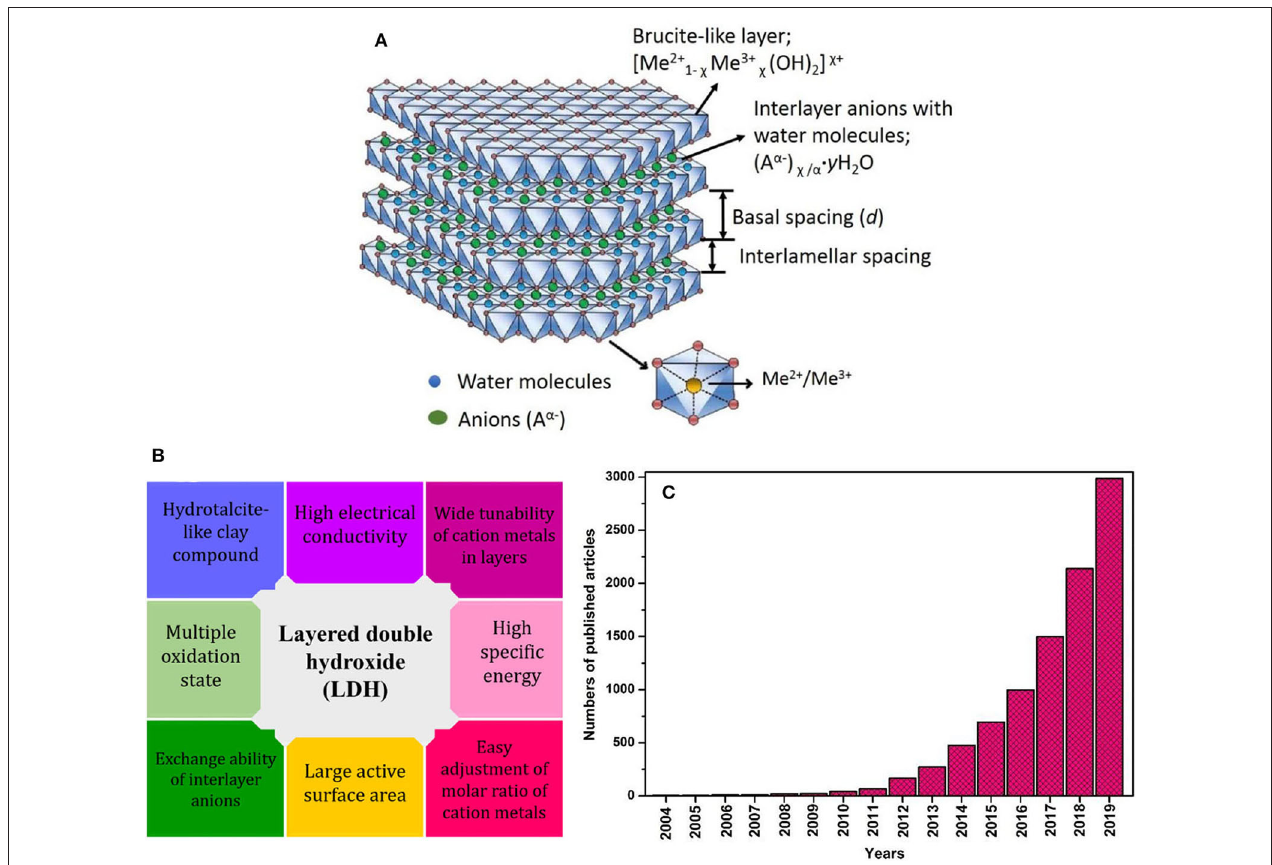
FIGURE 4 | (A) Schematic illustration of the layered double hydroxides structures (Sarfraz and Shakir, 2017), (B) properties of layered double hydroxides as suitable electrode material in supercapacitor, and (C) number of articles published on layered double hydroxides as electrode material in supercapacitors from 2004 to 2019 using the keyword “supercapacitor and layered double hydroxide” (Data is collected from Scopus on November 30, 2019).